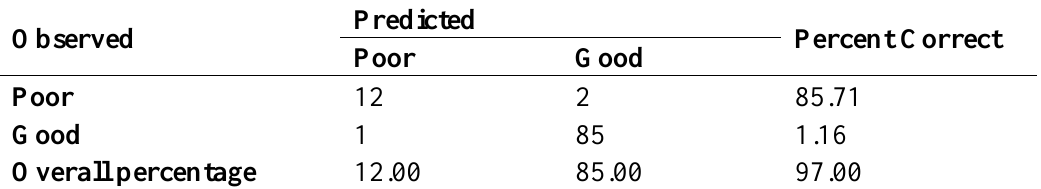
Table 7. Classification results using the level of riding quality model of highway number 3467 (100